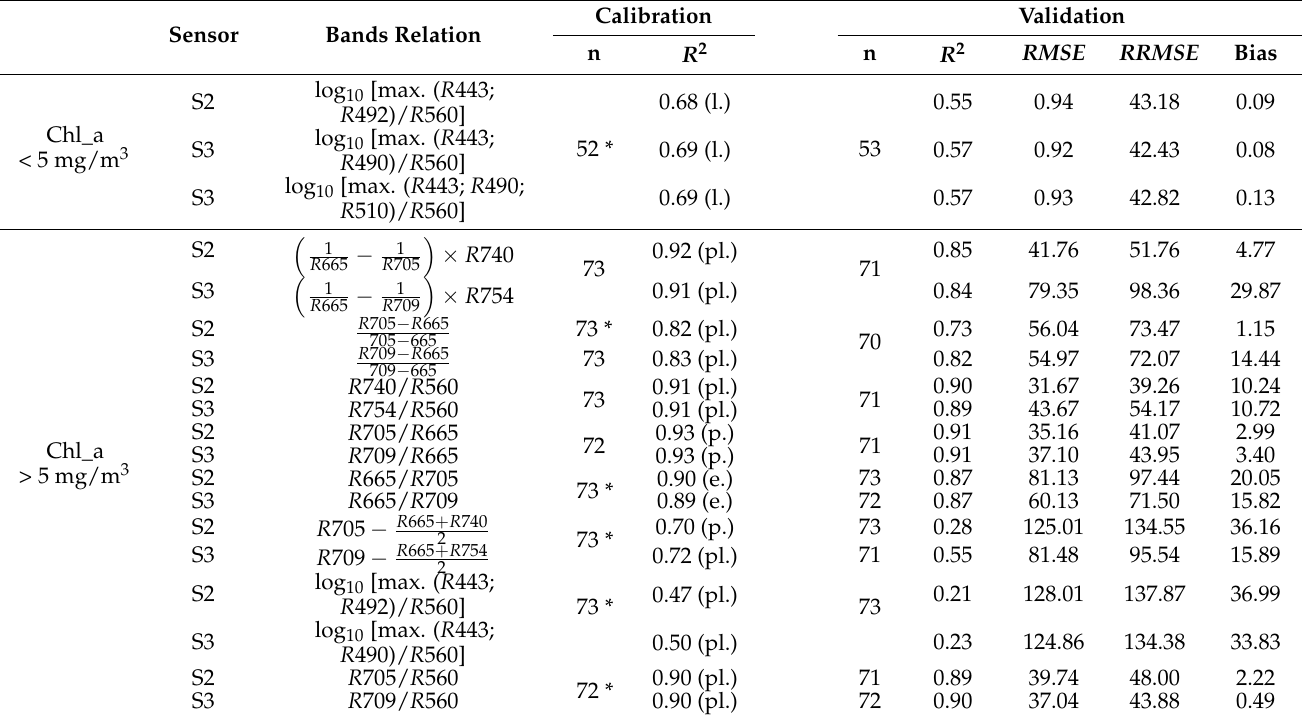
Table 8. Calibration and validation results for chlorophyll a (Chl_a). Only results with a calibration with R 2 > 0.4 are shown.